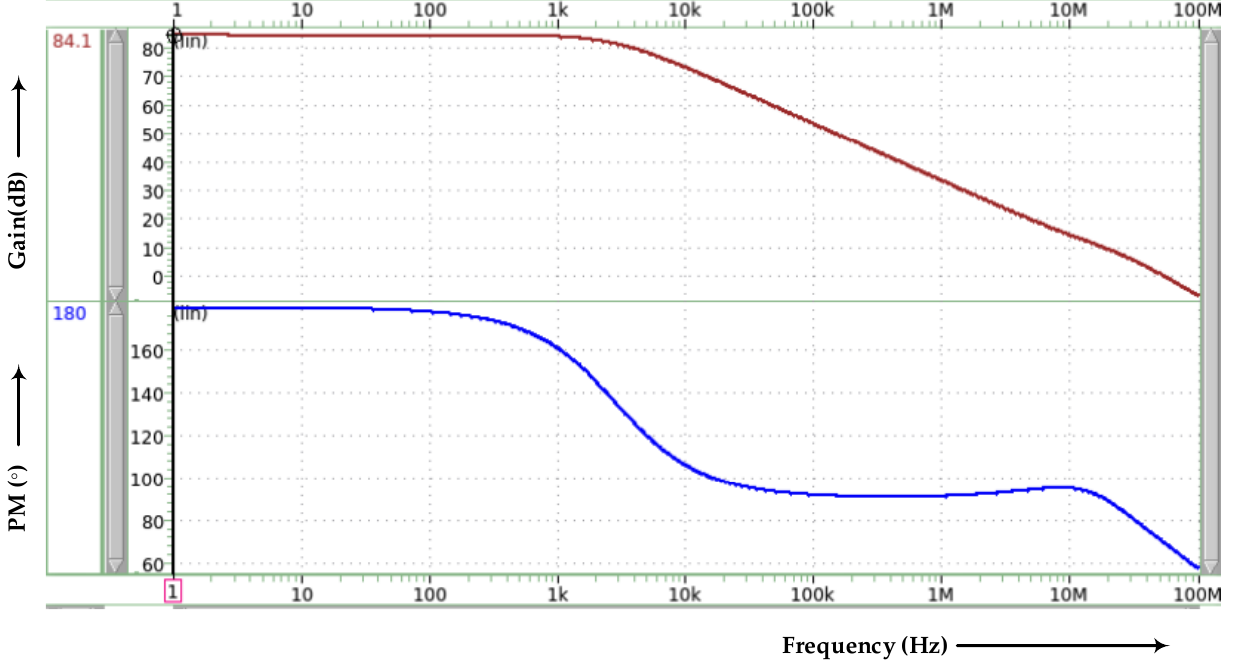
Figure 5. Bandgap reference op amplifier gain and phase margin analysis. Table 2. Summary of the operational amplifier PVT analysis.